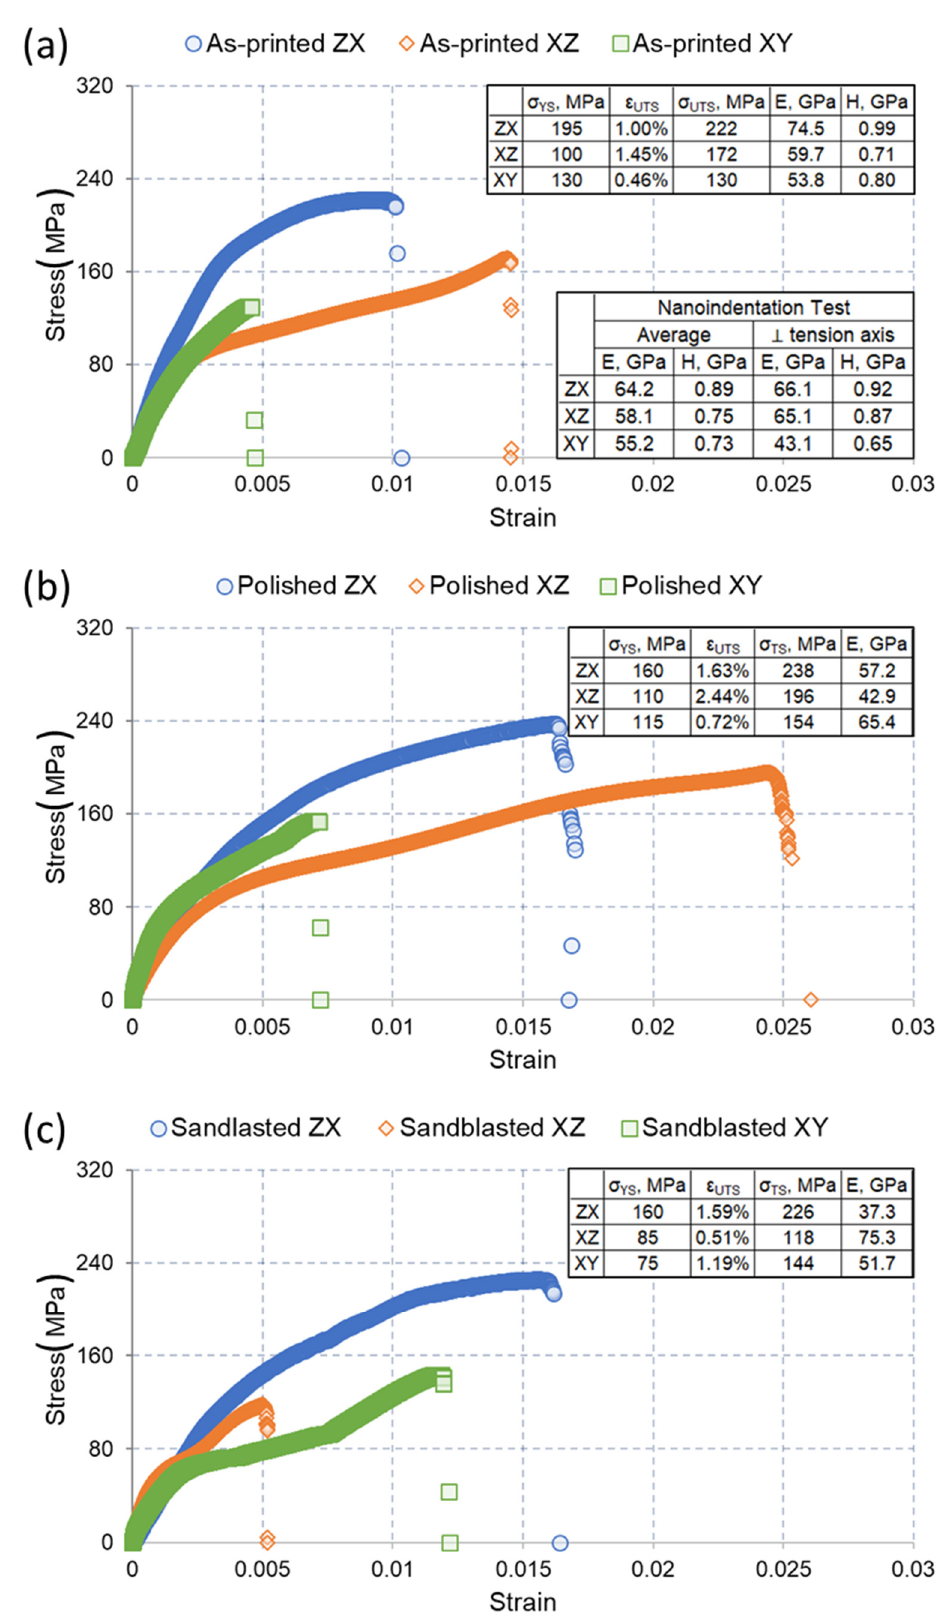
Figure 7. Mechanical response ( a – c ) of 3D-printed RS-333 Al alloy under tension.